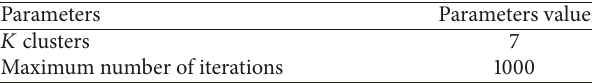
Table 4: 𝐾 -means algorithm